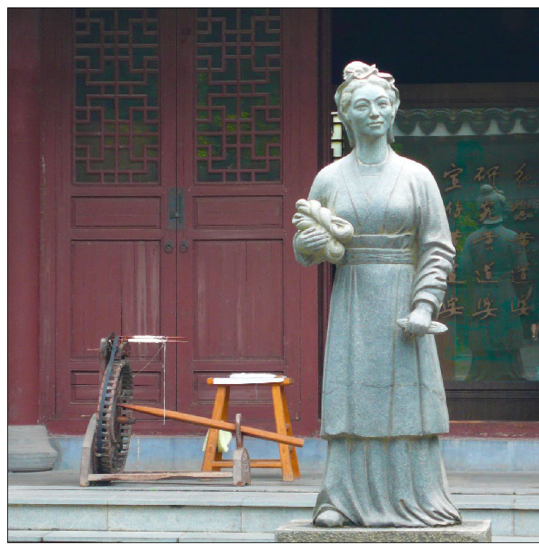
Fig. 1 Huang Daopo Memorial